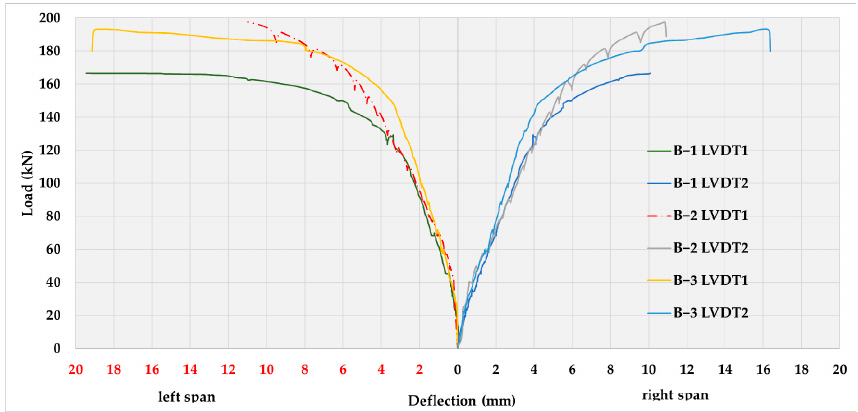
Figure 4. Load vs. deflection curves in Section I—left span and Section II—right span for tested Beams B − 1, B − 2 and B − 3.